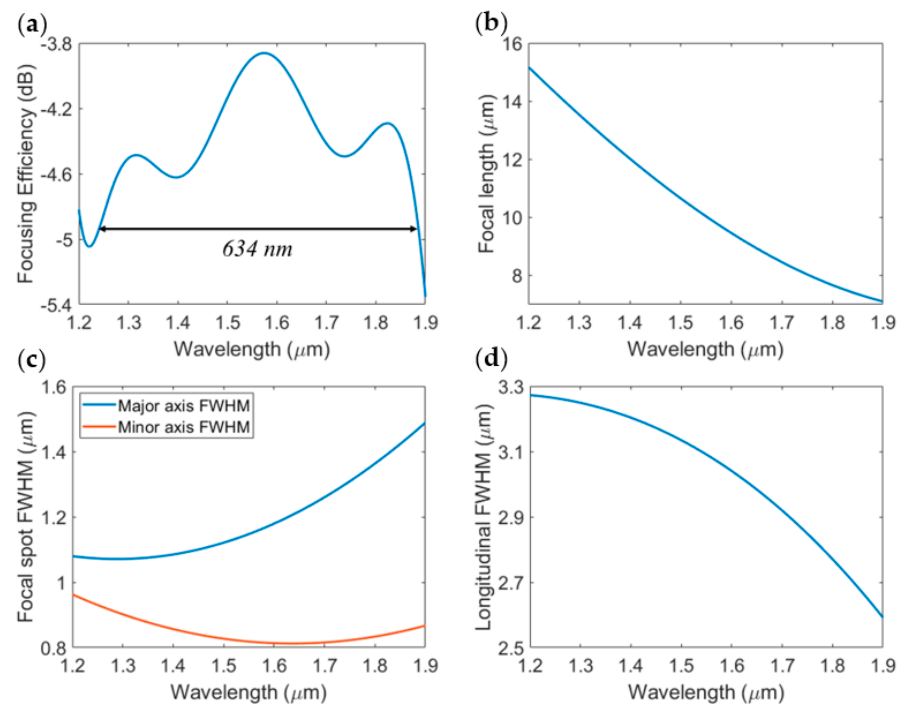
Figure 12. Wavelength dependence of ( a ) focal length, ( b ) focal spot transversal FWHM on major (blue) and minor (orange) axes, ( c ) focal spot longitudinal FWHM, and ( d ) the focusing efficiency of our proposed BPFZP with varying SWG duty cycle.